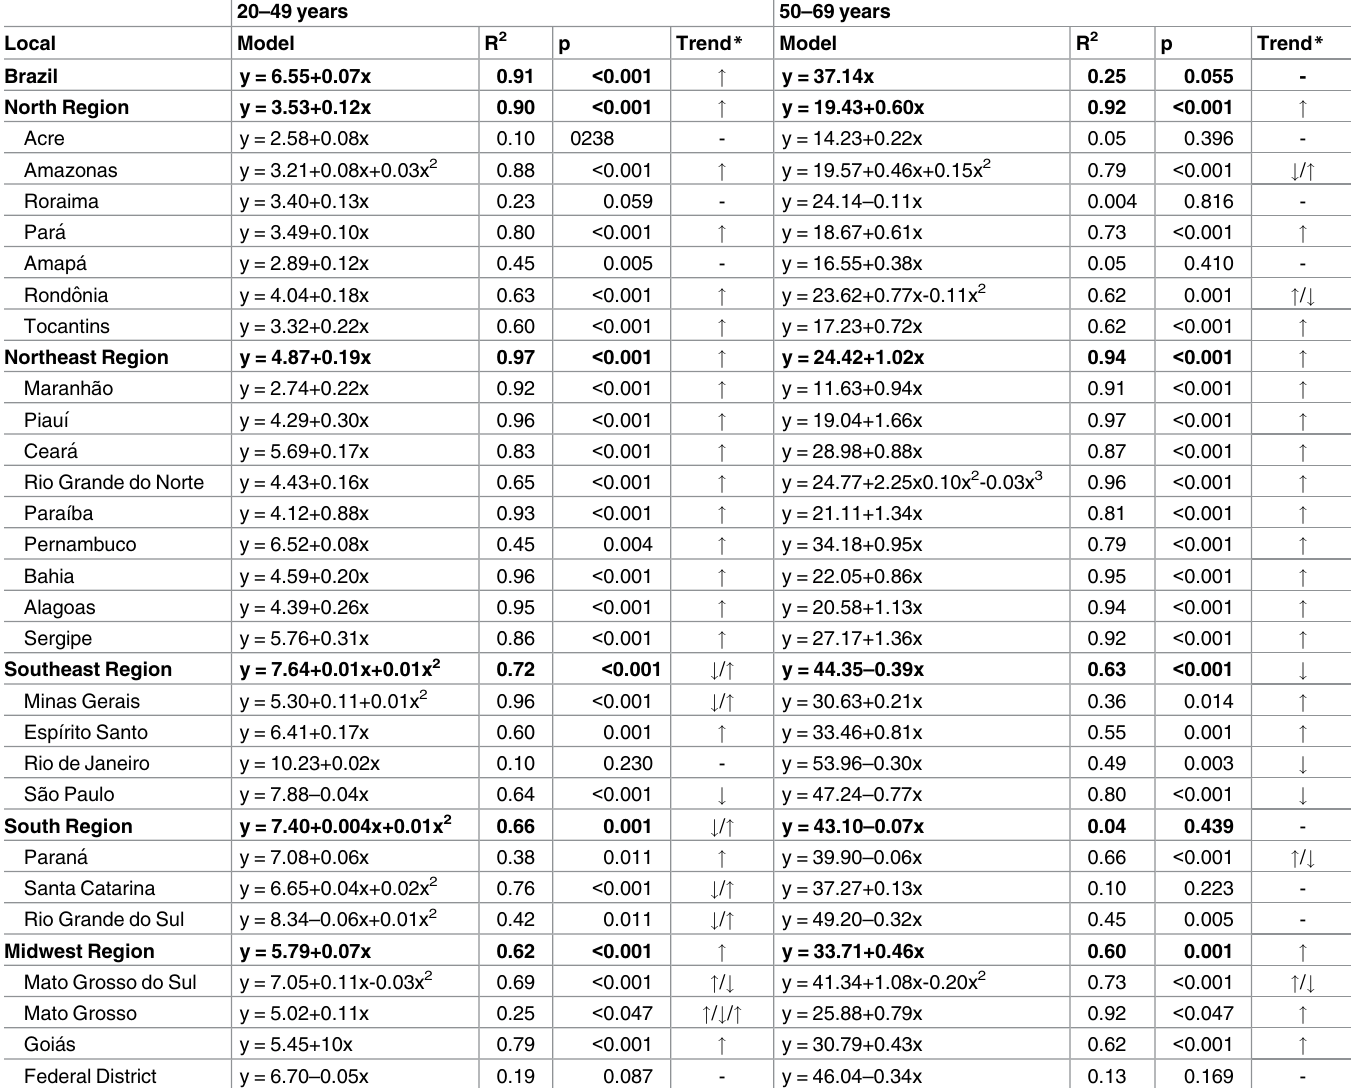
Table 2. Trend models of the mortality rates from breast cancer according to age. Brazil,